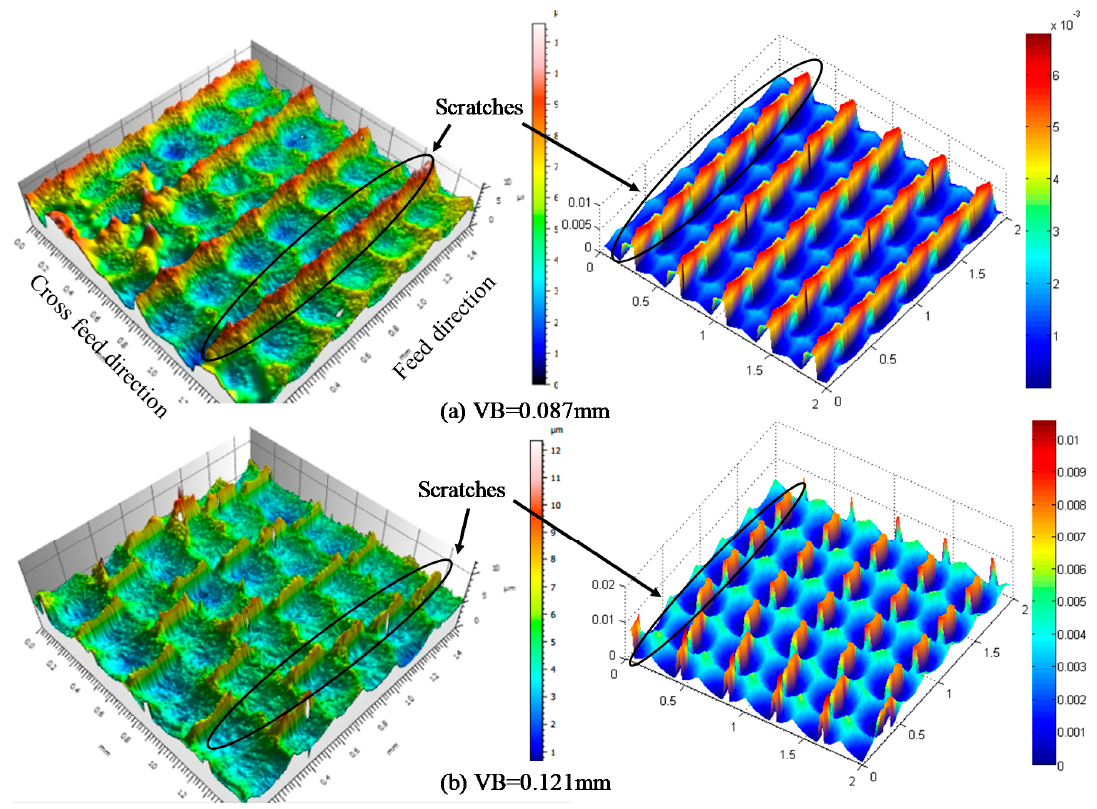
Figure 14. Surface morphology at different tool wear, Ra(um) ( a ) experiment—0.356; simulation—0.372;( b ) experiment—0.424; simulation—0.395.